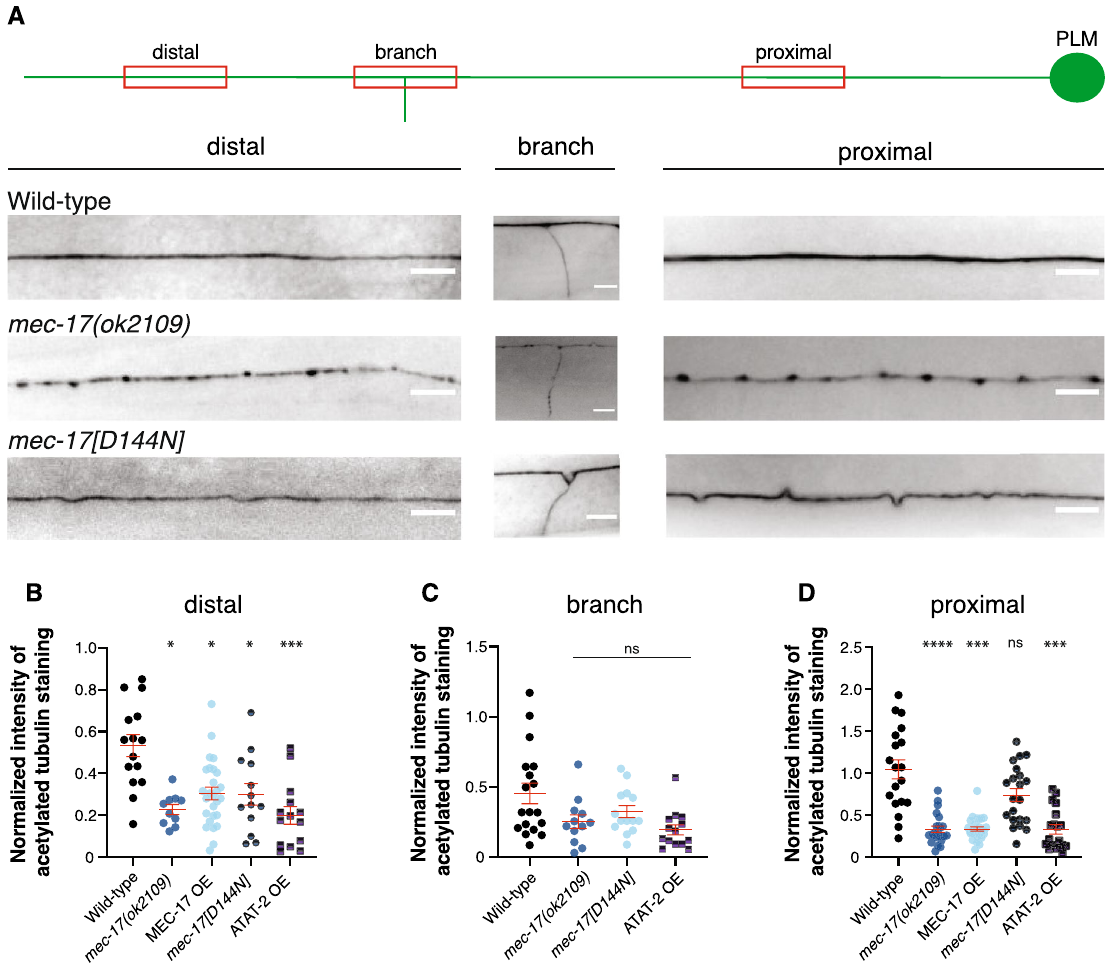
Figure 4. Quantification of α-tubulin acetylation levels. ( a) Schematic depicts the PLM neuron with its proximal, branch and distal regions highlighted in red, showing the approximate locations imaged for analysis. Maximum intensity projection images show the distal, branch and proximal regions of the PLM axon in animals stained for acetylated tubulin. The panels represent the distribution of acetylated tubulin in wild-type ( zdIs5 ) , mec-17(ok2109), and mec-17[D144N] animals. Scale bar is 5 µm. ( b) Quantification of normalized intensity of acetylated tubulin staining along the distal, ( c) branch, and ( d ) proximal regions of the PLM axon in gravid adults across the different genotypes. Background intensity was measured from pixels adjacent to the neuronal process, and normalized intensity was calculated by using the formula (I (signal) – I (background) )/I (background) . Data is represented as a scatter dot plot with outliers removed and standard error of the mean marked by red lines. All genotypes are compared to wild-type ( zdIs5 ). P -values * < 0.05, *** < 0.001, **** < 0.0001 obtained by comparing the mean rank of each distribution from the Kruskal–Wallis H test, followed by Dunne’s multiple comparisons test. Each genotype has n > 15 animals